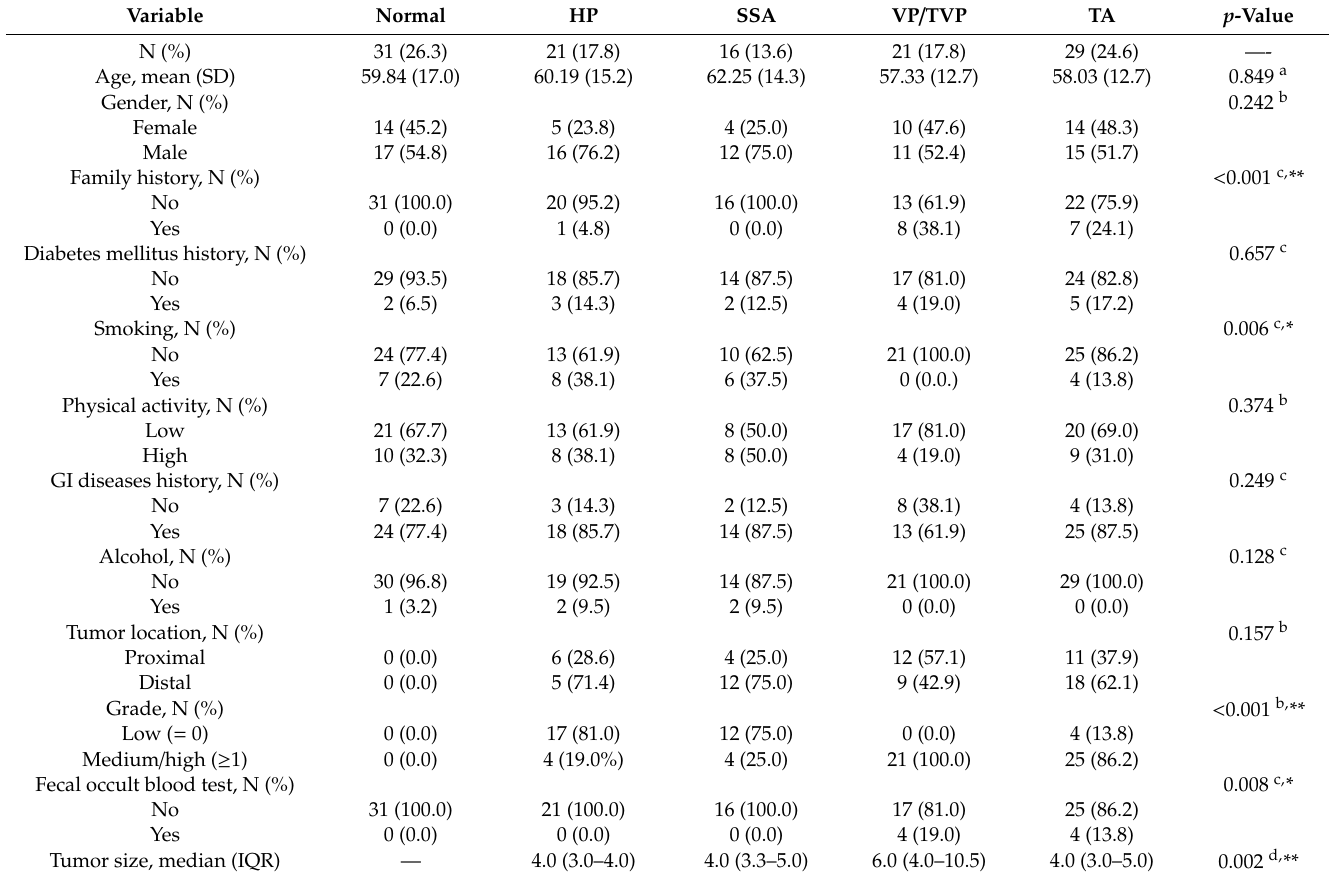
Table 1. Patient demographics in normal, hyperplastic polyp (HP), sessile serrated adenoma (SSA), tubular adenoma (TA), and villous / tubulovillous (VP / TVP)